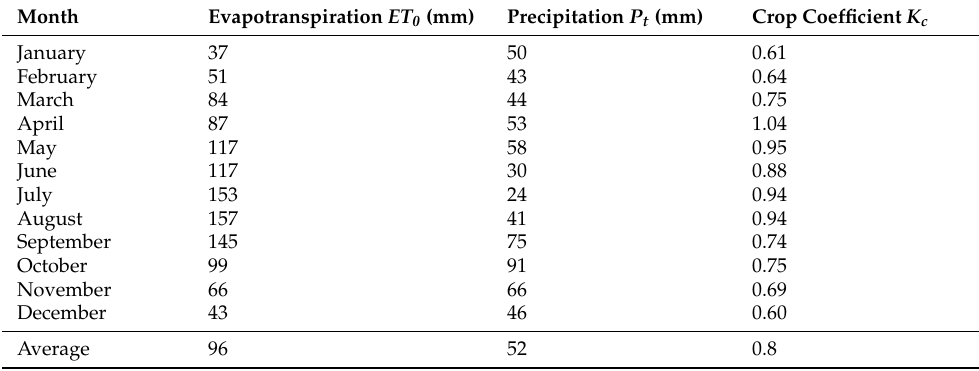
Table A3. Climatic conditions and crop coefficients for garden water use. Month Evapotranspiration ET 0